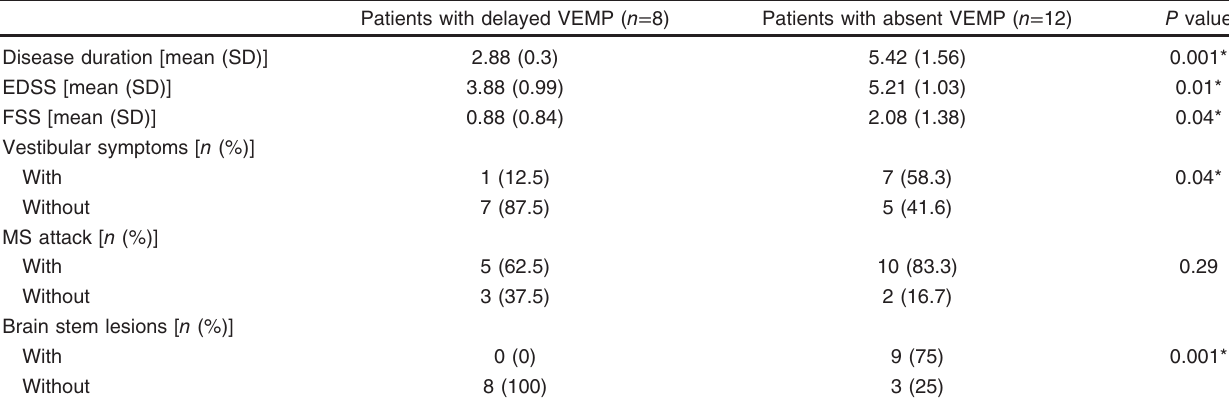
Interaural amplitude ratio (IAAD) IAAD, interaural amplitude difference; VEMP, vestibular-evoked myogenic potential. P ≥ 0.05, nonsignificant. * P < 0.05, significant. Table 5 Comparison between patients with delayed vestibular-evoked myogenic potential latency and those with absent vestibular-evoked myogenic potential wave in disease characteristics Patients with delayed VEMP ( n = 8) Disease duration [mean (SD)]